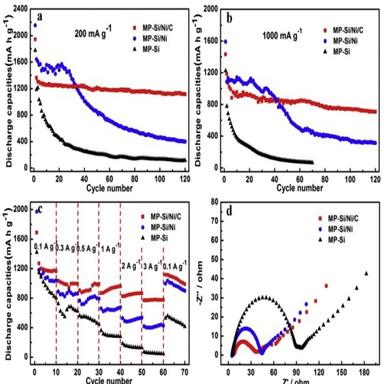
Cycling performances of three electrodes under the current density of 200 mA g¡1 (a), 1000 mA g¡1 (b), rate performance (c), and impedance spectra (d).